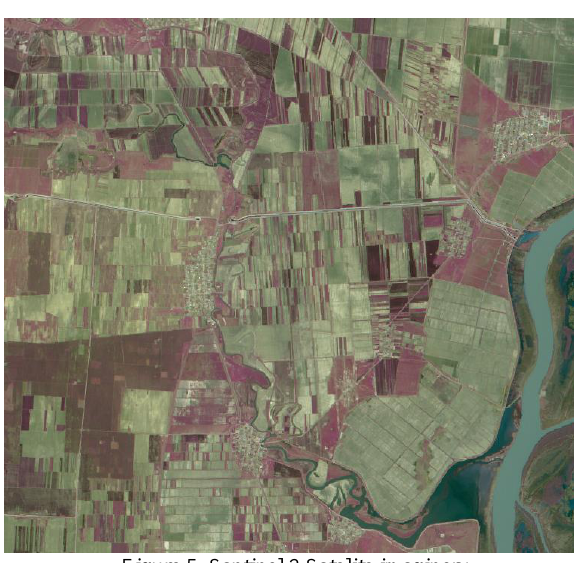
Figure 5. Santinel 2 Satelite imaginery Band combinations for different satellite imaginary offers valuable information, in close relation to an apropriate